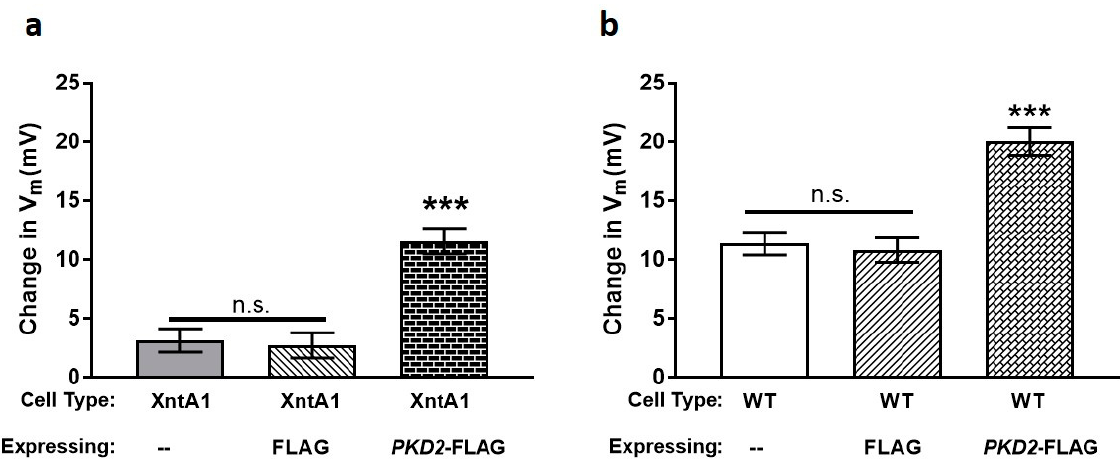
Figure 6. Over-expression of PKD2 -FLAG restores Mg 2 + permeability of XntA1 mutants to WT levels and increases membrane permeability to Mg 2 + in WT cells. The average ∆ V m of ( a ) XntA1 mutant cells or ( b ) WT cells and those cell types over-expressing FLAG or PKD2 -FLAG. Cells were recorded in 1 mM KCl without, and then with, 0.5 mM MgCl 2 . Results are average ∆ V m in mV ± SEM (N = 7 to 11 cells). *** = p < 0.0001 (T-tests) compared to ( a ) XntA1 mutants and XntA1 mutants over-expressing FLAG or ( b ) WT cells and WT cells over-expressing FLAG; n.s. with bar = not significantly different.